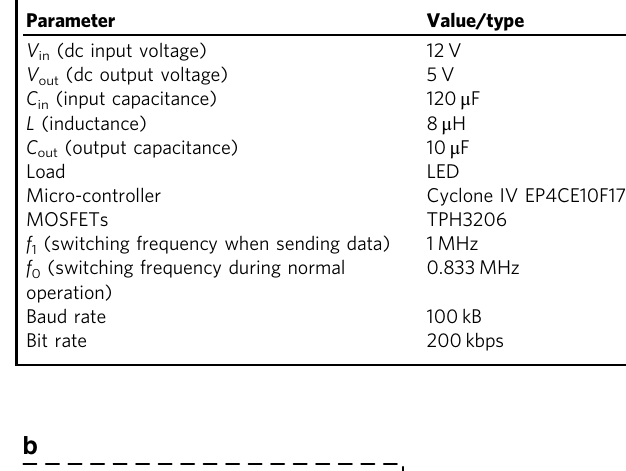
Table 3 Experimental parameters of the buck/boost converter in the LED lighting